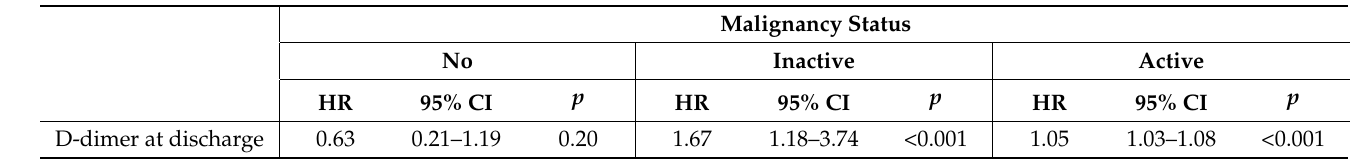
Table 5. Univariable Cox proportional hazard model analysis for all-cause death in the malignancy